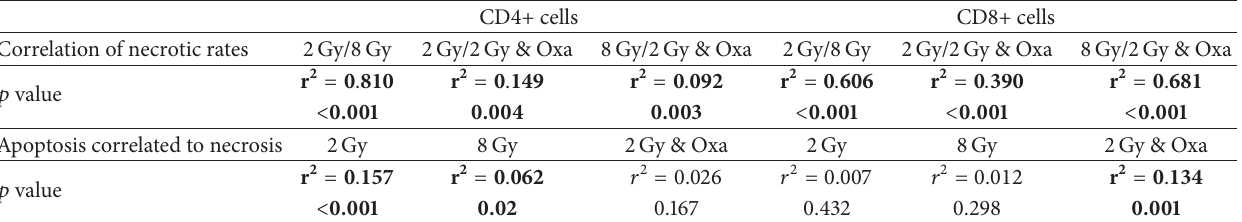
Table 2: Correlation of necrotic rates of the different treatments for CD4+ and CD8+ lymphocytes separately and correlation of apoptosis and necrosis rate of CD4+ and CD8+ cells regarding the three different treatments ( 𝑝 values < 0.05 are highlighted in bold). CD4+